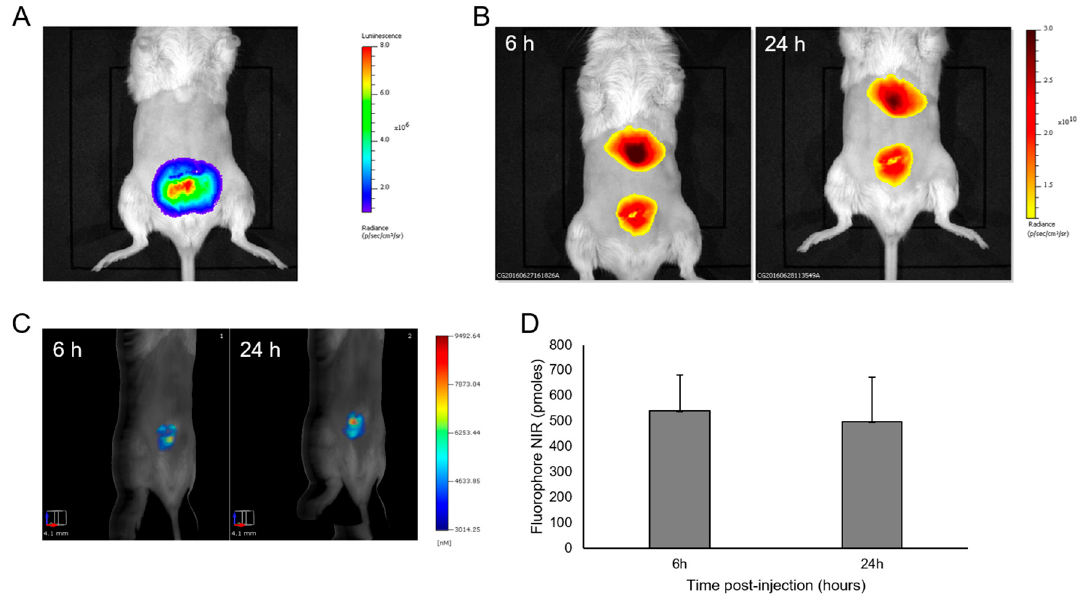
Figure 2. In vivo detection of LipImage TM 815 accumulation in orthotopic prostate tumors. ( A ) Bioluminescence image of a representative mouse; ( B ) FRI and ( C ) FMT of a representative mouse 6 h and 24 h after LipImage TM 815 injection; ( D ) FMT-based quantification of LipImage TM 815 accumulation in the prostate tumor. Mean ± standard deviation.